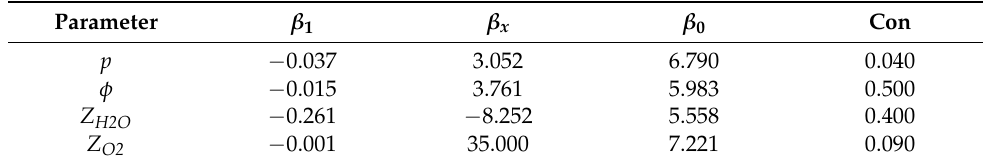
Table 1. Fitting parameters for different initial conditions.